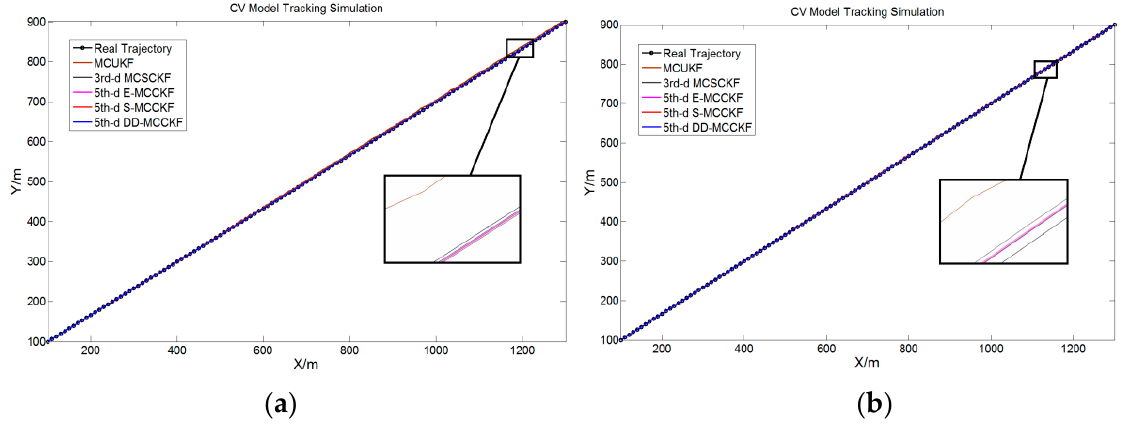
Figure 4. Tracking trajectories of a surface target (unmanned surface vessel) under non-Gaussian noise conditions (( a ) is the result under Equation (61) and ( b ) is the result under Equation (62)).